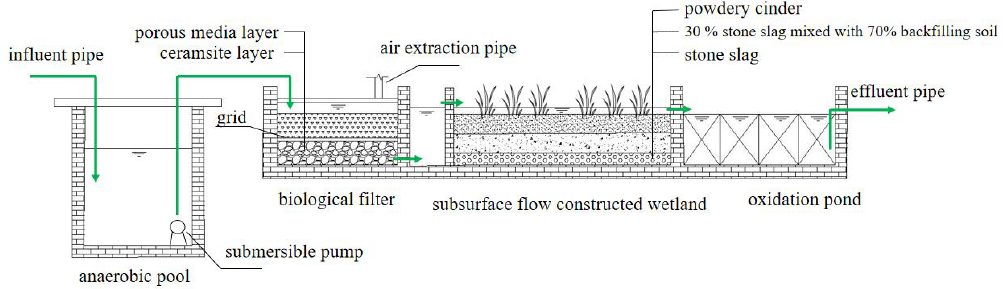
Figure 1. Schematic diagram of the apparatus.